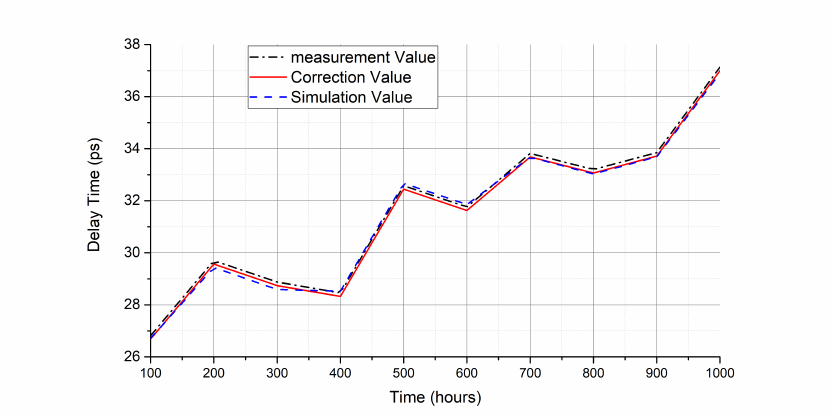
Figure 7. Comparison of the correction delay and simulation delay.